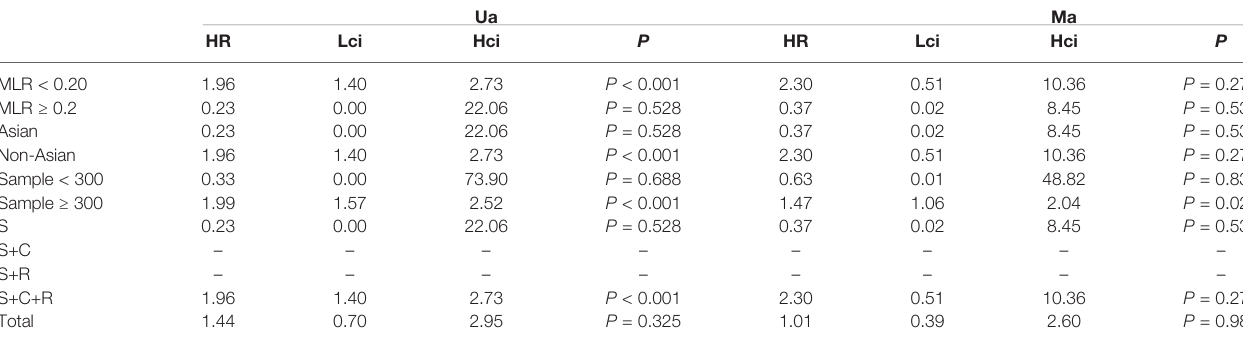
TABLE 7 | The results of the subgroup analysis for monocyte – lymphocyte ratio (MLR) and overall survival are summarized below.